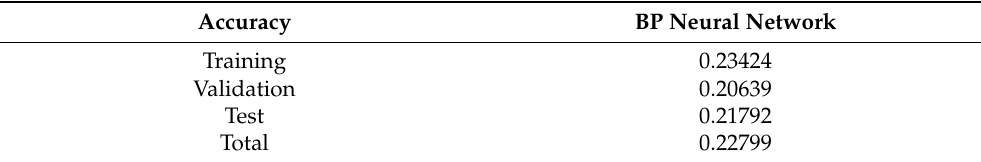
Table 3. BP neural network